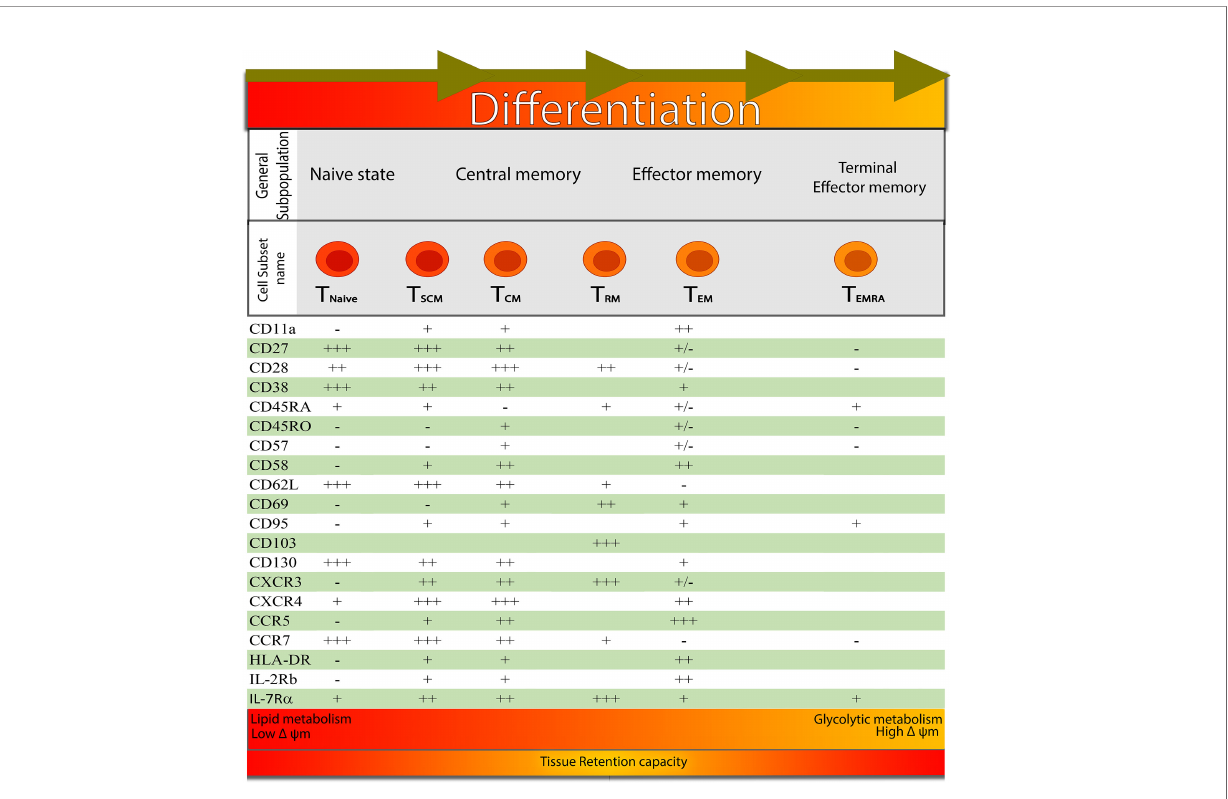
FIGURE 1 | Signatures for distinguishing the different developmental T cell stages: from left to right, it shows the different development stages of CD8 + T cell-based on the expression of surface markers. At the bottom of the fi gure, the main metabolic pathway and mitochondrial membrane potential that are favoured at the functional and phenotypic stage are represented by different coloured gradients (from red to orange), indicating that T RM cells have a larger tissue retention